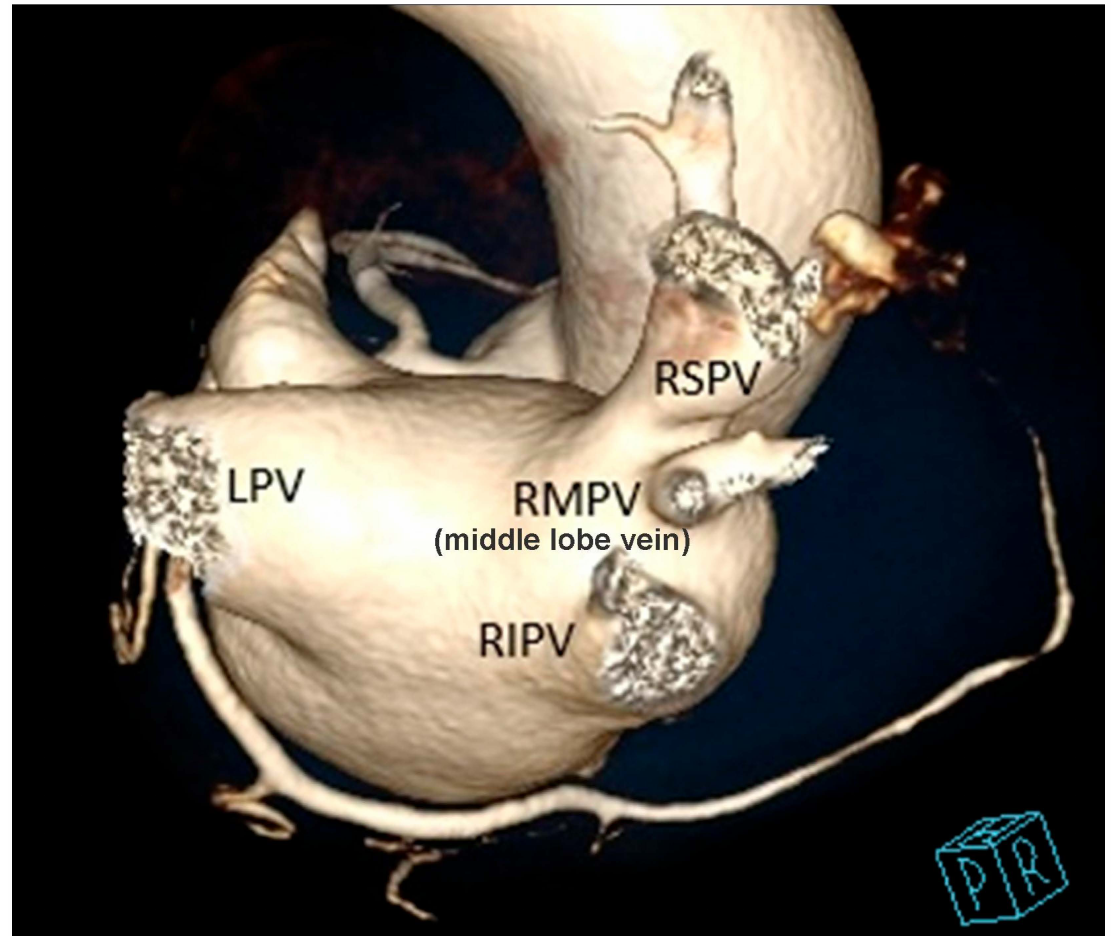
Figure 5. Cardiac computed tomography angiography. Angiographic phase. Volume Render- ing Technique (VRT) reconstruction. Cranial-posterior-right oblique view. Pulmonary venous drainage to the left atrium—accessory right middle pulmonary vein. RSPV—right superior pul- monary vein, RMPV—right middle pulmonary vein, RIPV—right inferior pulmonary vein, LPV—left pulmonary